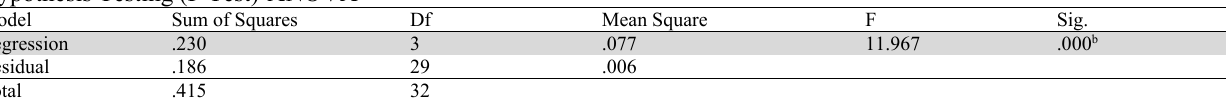
Hypothesis Testing (F